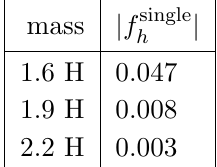
Figure 6 . Shape sensitivity of F single which F single h